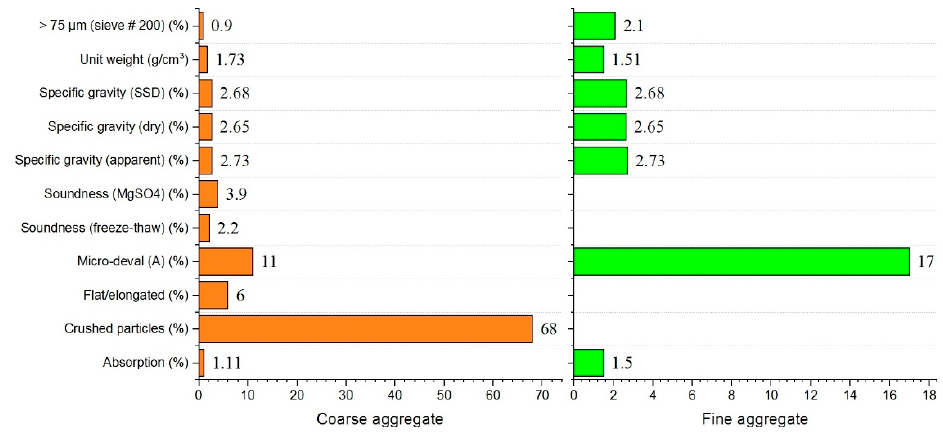
Figure 2. Physical and chemical properties of fine and coarse aggregates. Table 1. Properties of materials used.